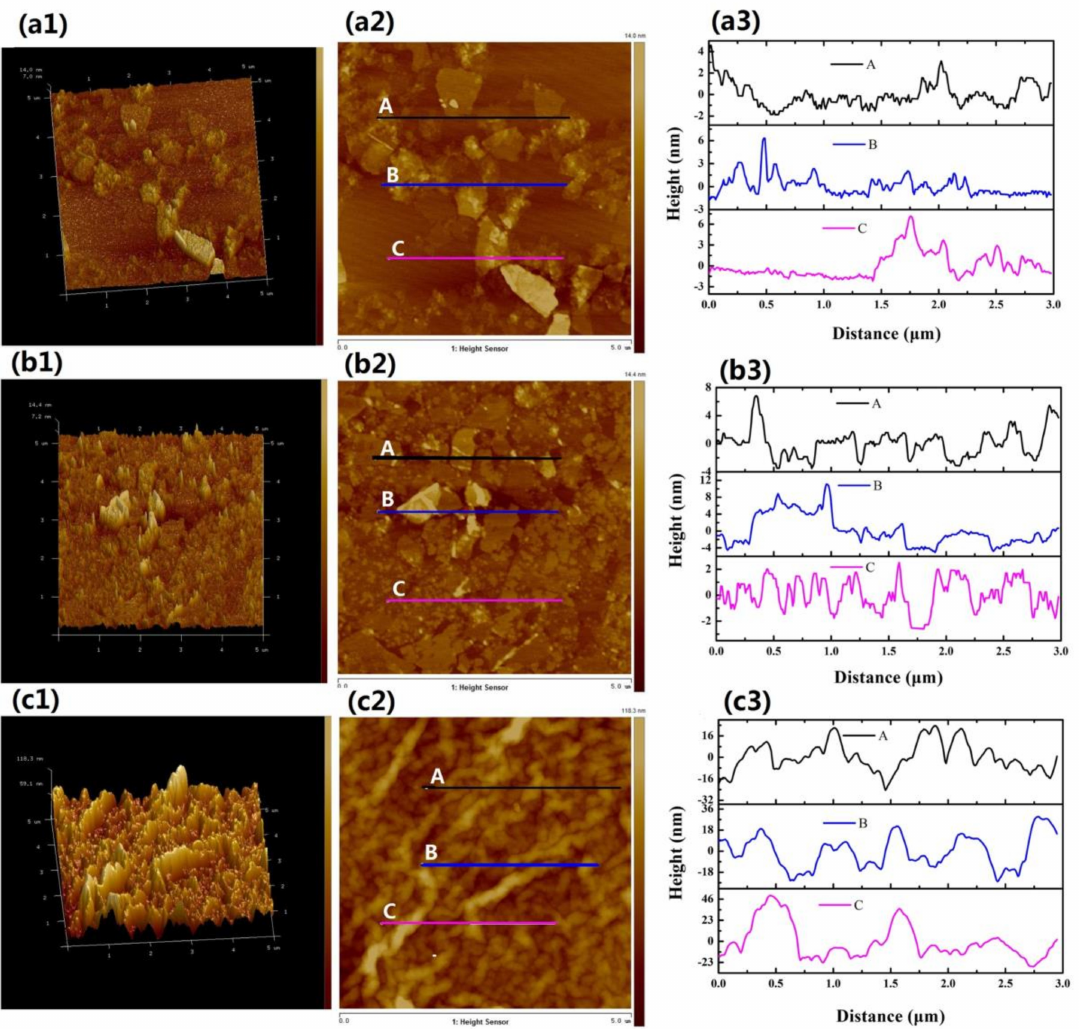
Figure 5. Atomic force microscope (AFM) of GO SA films GO-22 ( a ), GO-38 ( b ) and GO-Drop ( c ). ( a1 , b1 , c1 ) are 3D topographical images; their corresponding 2D topographical images are shown in ( a2 , b2 , c2 ), respectively; thickness profiles are shown in ( a3 , b3 , c3 ),